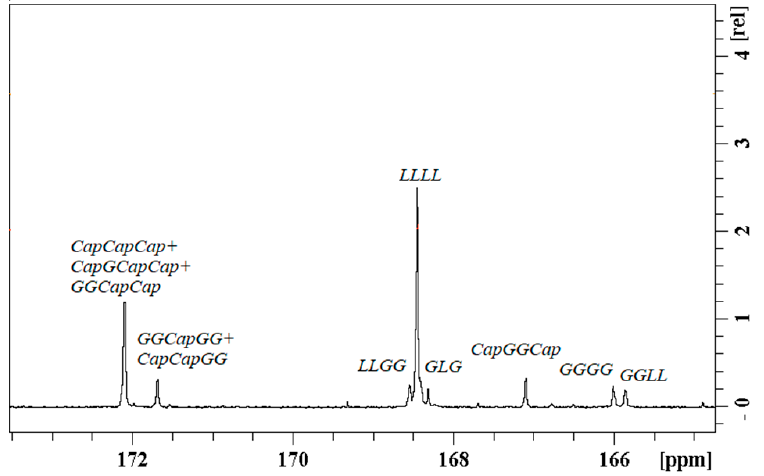
Figure 9. Carbonyl carbon range (C=O) of the 13 C NMR spectrum of (PGCL/PLGA) + CTX. Signals are described according to the nomenclature presented in previous publications [23,24].